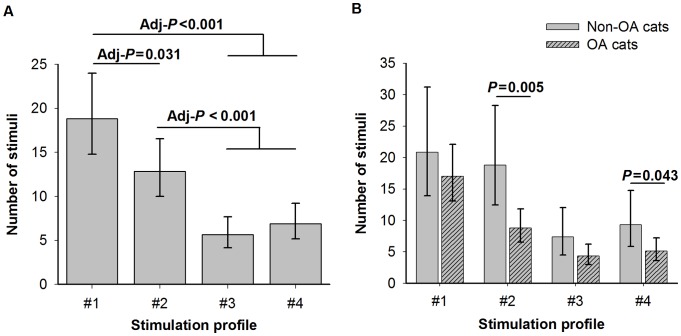
Number of stimuli reached and 95% confidence interval (inverse link of the least squares means estimates and 95% confidence interval obtained using the Poisson generalized linear modelling) following repetitive mechanical stimuli: A- by stimulation profiles (#1 to 4); B- by stimulation profiles and osteoarthritis (OA) status.Adj-P =  adjusted p-value.